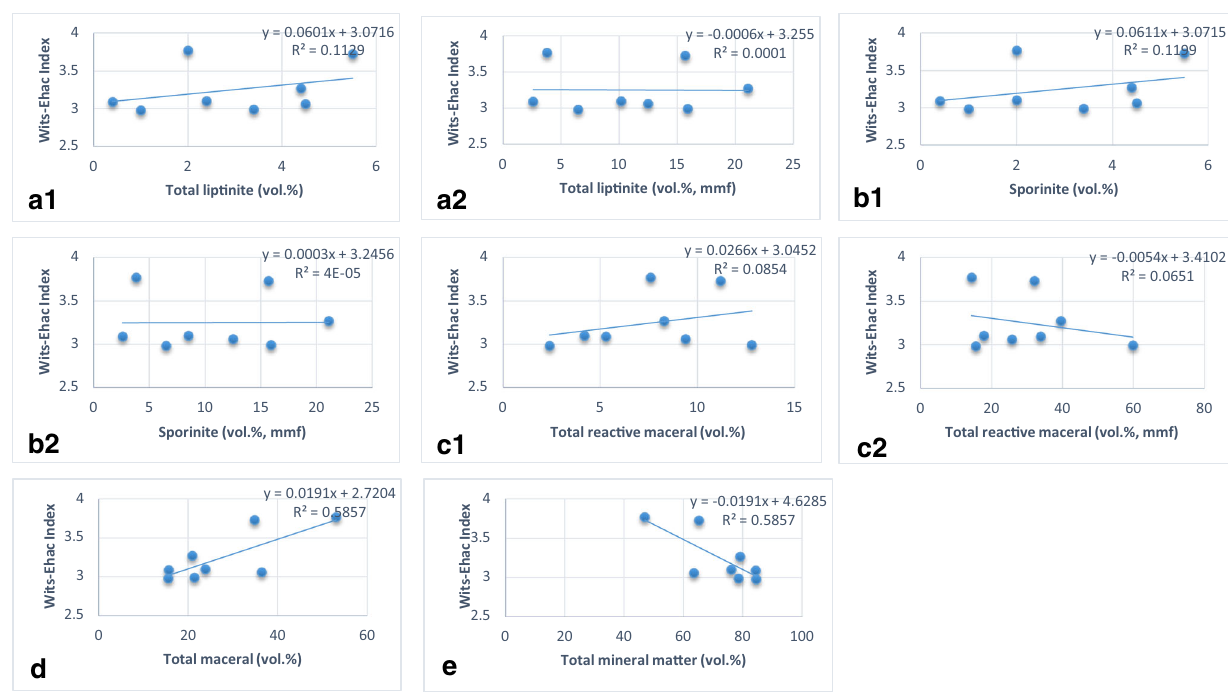
Fig. 15 Influence of liptinite, other macerals and petrographically observable mineral matter on spontaneous combustion of